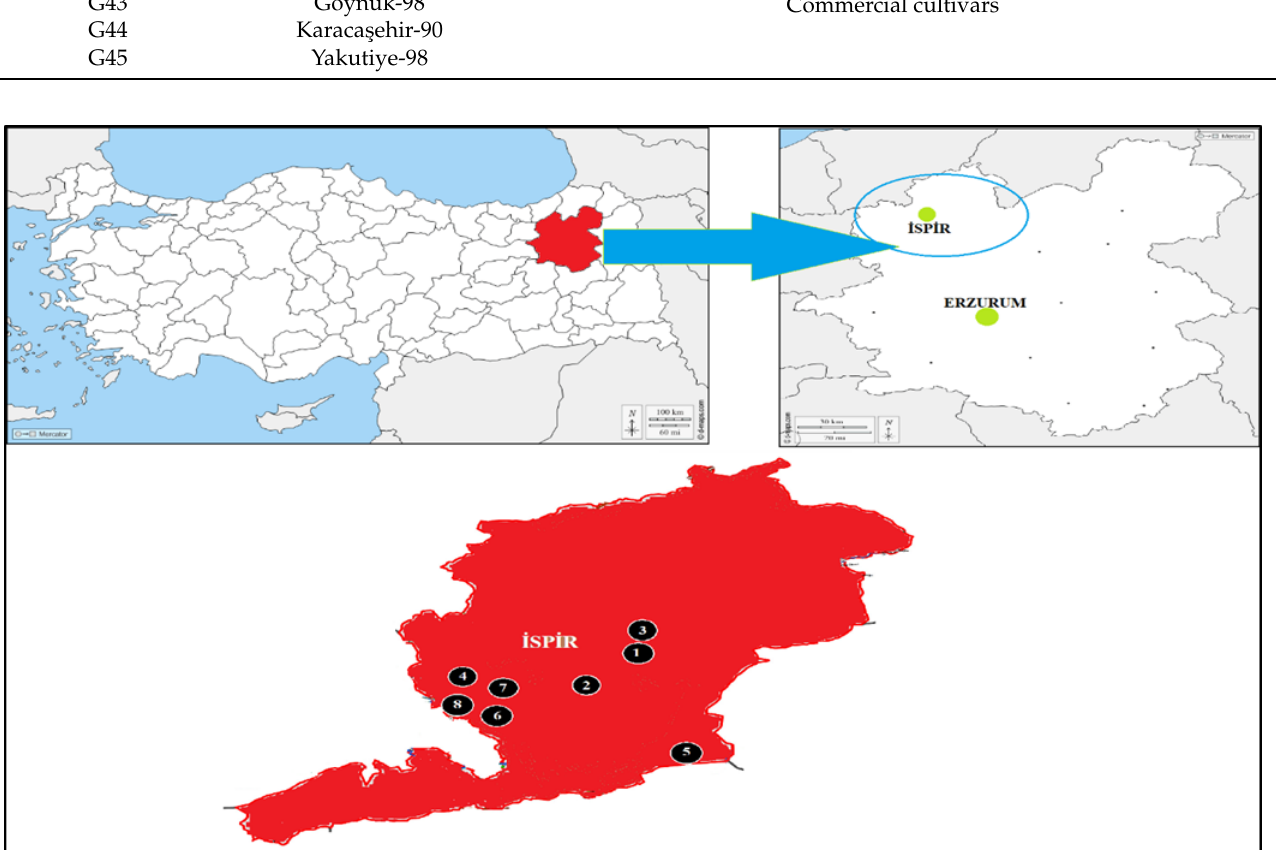
Figure 1. Locations where local bean varieties were collected (Table 1; 1: Öztoprak village, 2: Ispir Center, 3: Yeşilyurt, 4: Maden Village, 5: Elmalı District Ağıldere village, 6: Ulubel village, 7: Kirazlı village, 8: Köprübaşı town . Commercial cultivars are not shown on the map).